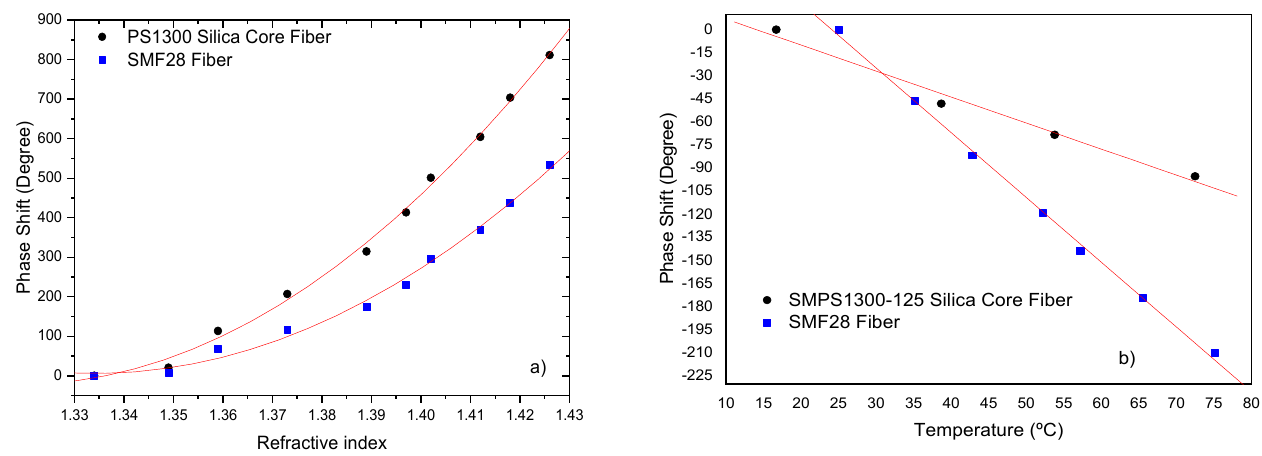
Figure 17. Comparison of phase changes using silica-core fiber and SMF 28 fiber (sensing length of 85 mm): ( a ) due to refractive index variations; ( b ) due to temperature.